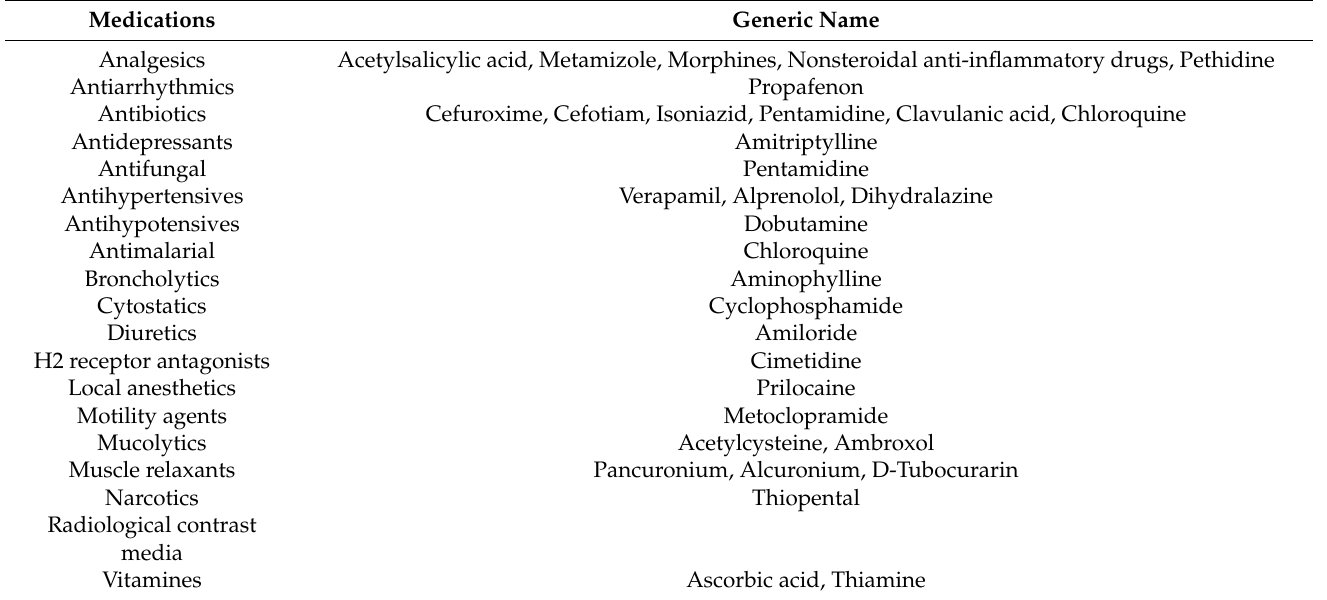
Table 2. Medications which may influence diamine oxidase and/or